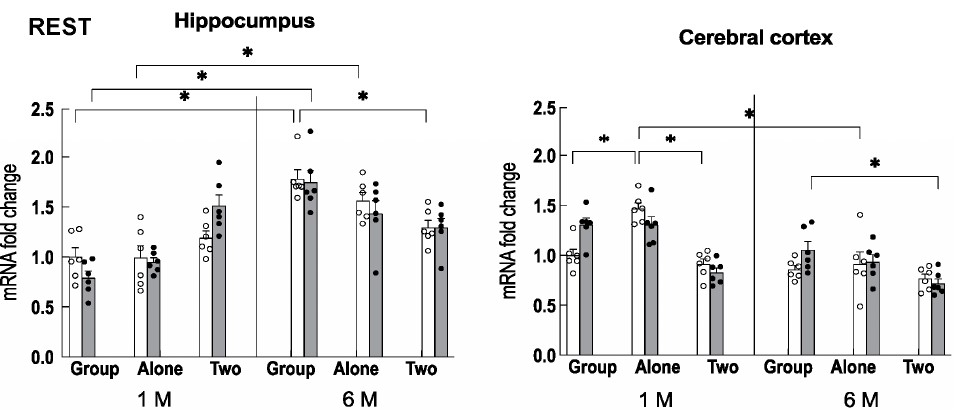
Figure 3. The expression of REST in the hippocampus and cerebral cortex under each rearing condition for 1 month (1 M, 2 months old) and 6 months (6 M, 7 months old) in control mice (open column) and theanine-ingesting mice (closed column). Each column bar represents the mean ± SEM (n = 6) overlaid on scatter plots (* p < 0.05, Tukey’s honestly significant difference method).